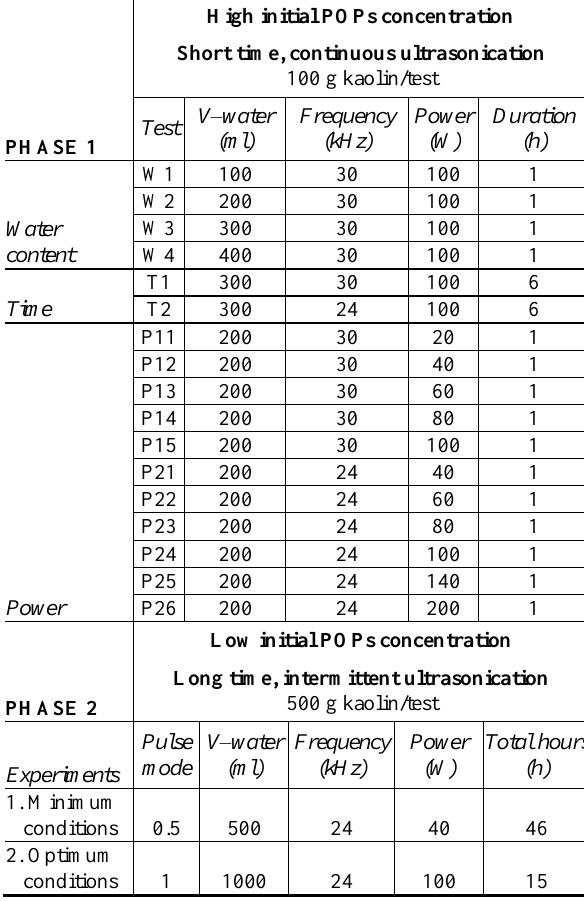
Table 2. Summary of experimental conditions for ultrasound- assisted tests during Phase 1 and Phase 2